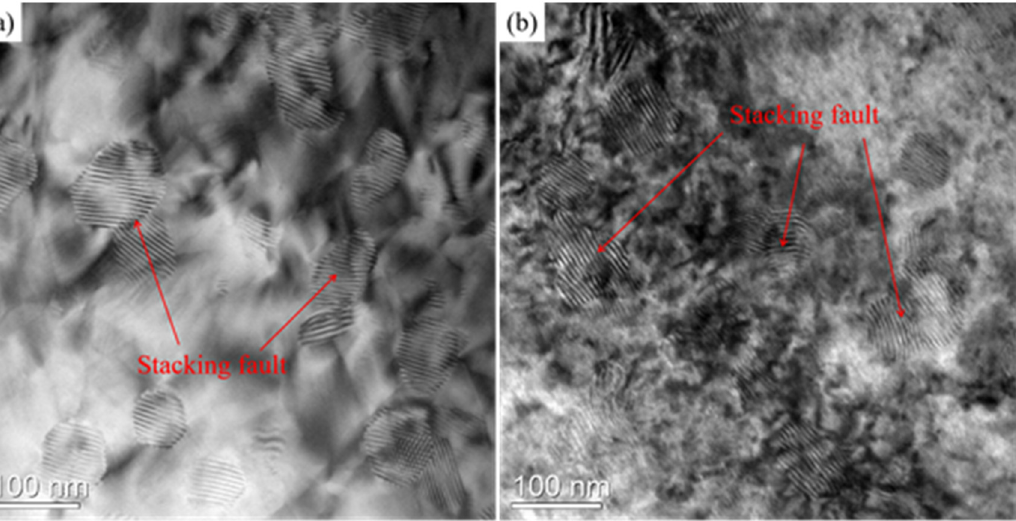
Figure 5. TEM images of stacking faults in the present alloy at ( a ) 523 K and 1 × 10 − 2 s − 1 and ( b ) 573 K and 5 × 10 − 4 s − 1 .